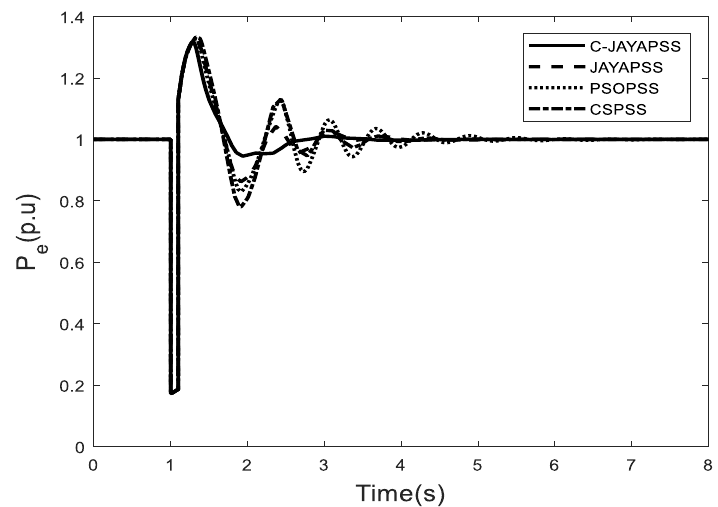
Figure 8. Rotor speed response for a six-cycle fault disturbance with case 1.